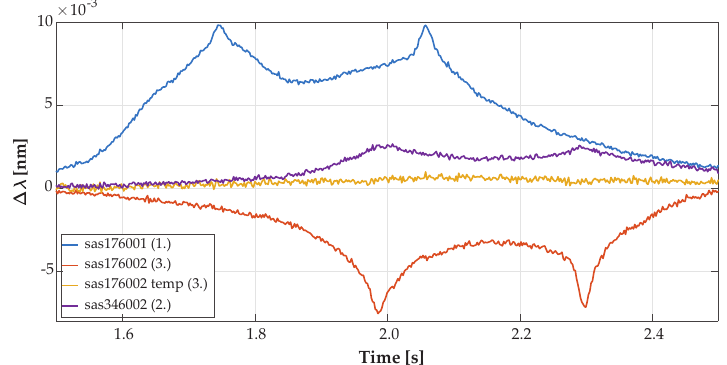
Figure 8. Record detail of axle detection from horizontal FBG sensors from the overpassing vehicle with an optimal traffic line as reflected in the optical spectrum wavelength change detected by the FBGs.